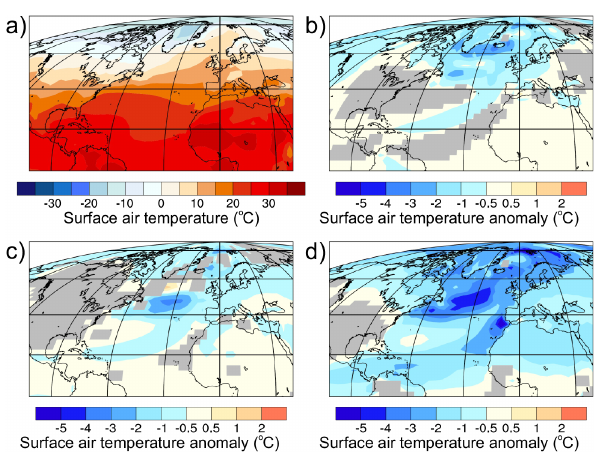
Fig. 9. North Atlantic annual mean surface air temperatures (in ◦ C) for (a) Messinian control and annual mean surface air temperature anomalies, given with respect to Messinian control , for (b) halite- quarter , (c) gypsum-half and (d) fresh-normal . The magnitudes of some of the local anomalies are difficult to identify, especially in the high latitudes, but numbers quoted in the text are accurate. Anoma- lies with < 95% confidence in significance using a student t test are masked in light grey.